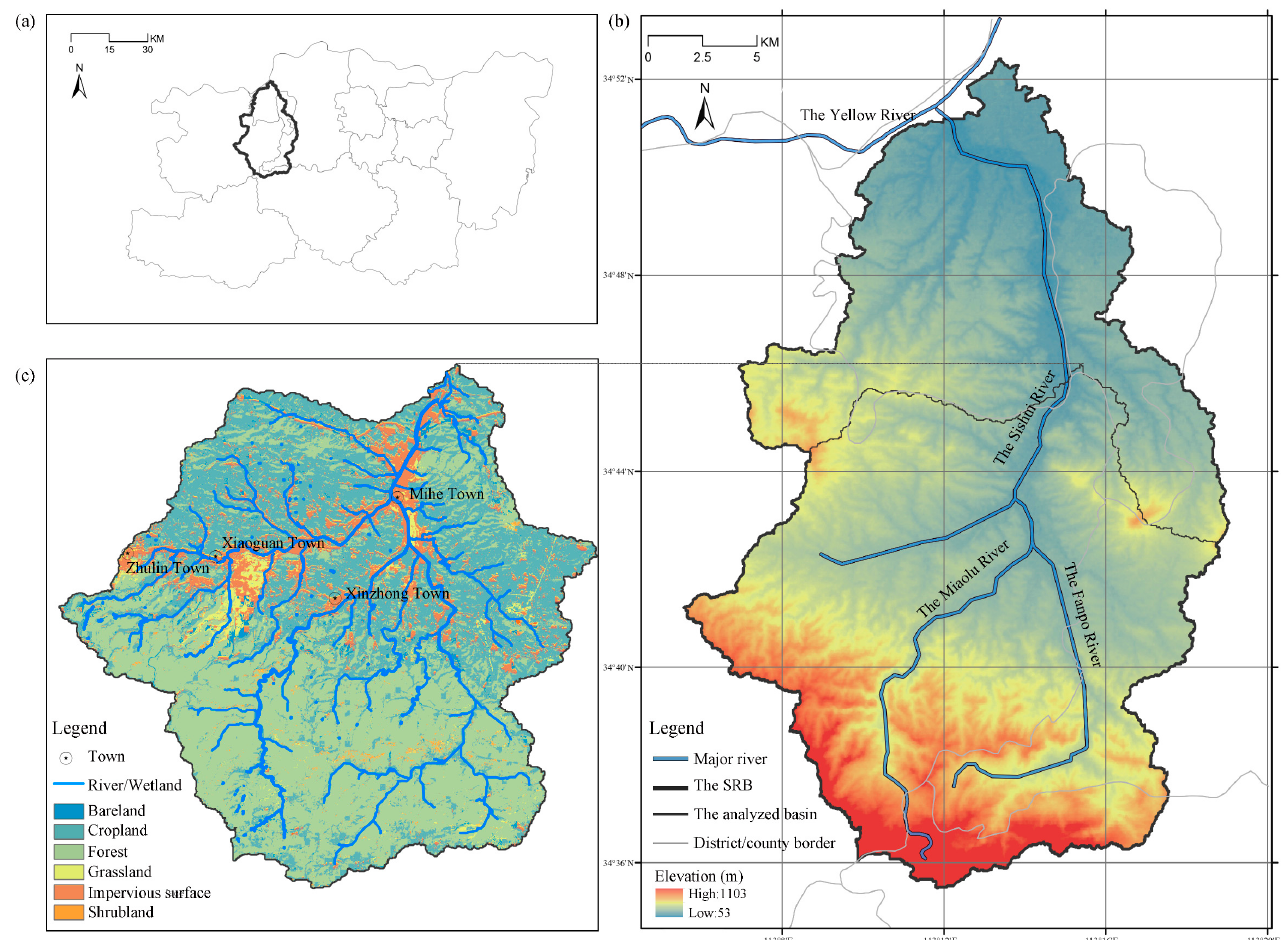
Figure 5. Basic geographic characteristics of the study area. ( a ) The location of the Sishui River Basin (SRB) in Zhengzhou; ( b ) Basic information of the SRB; ( c ) Basic information of the analyzed sub-basin.